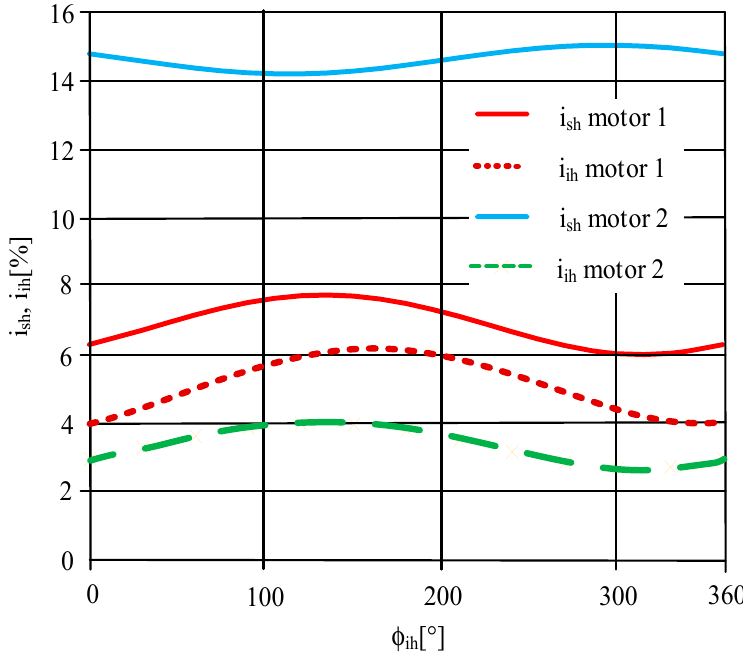
Figure 10. Current subharmonics and interharmonics versus the angle φ ih for φ sh = 0 ◦ , the work with a constant rotational speed, voltage fluctuation of the frequency equal to f m = 7 Hz and f m = 30 Hz for motor1, motor2, respectively.